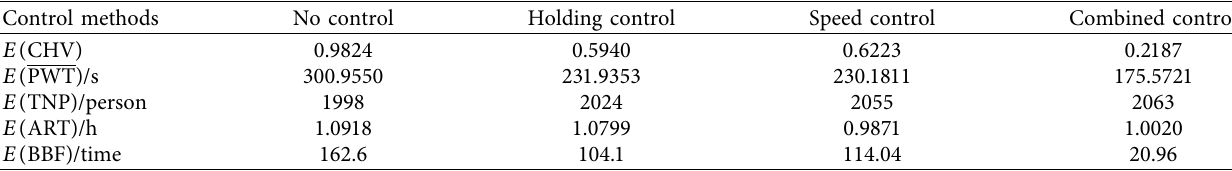
Table 3: Performance of different methods.